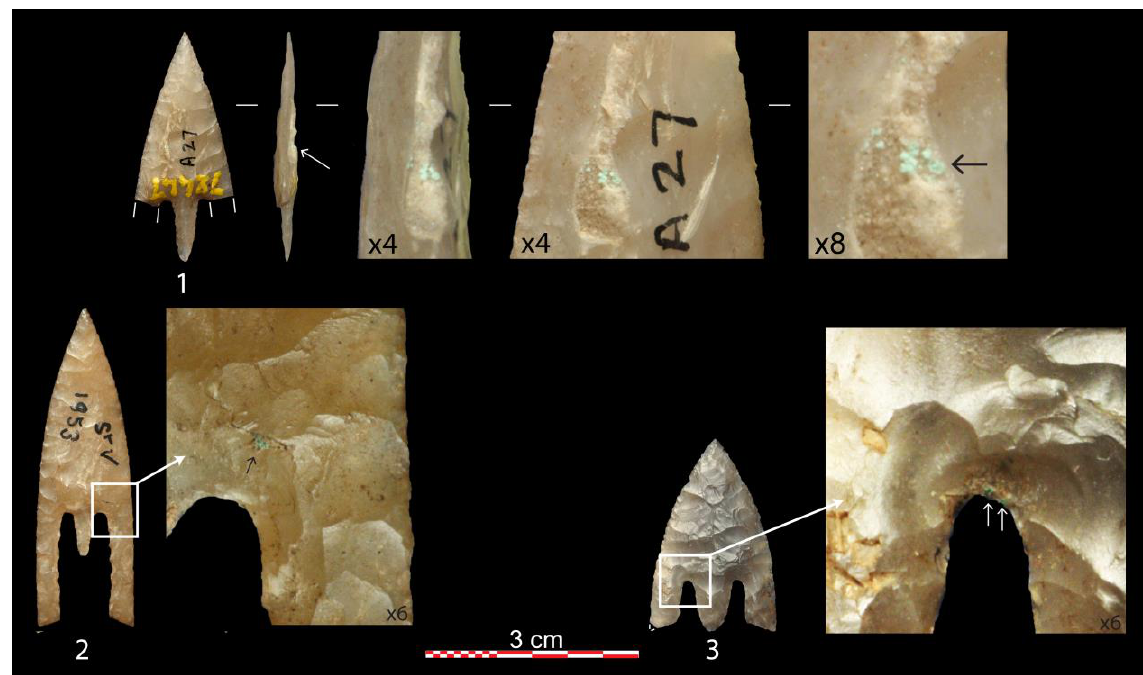
Figure 8. Greyish green traces on Armorican arrowheads indicating the use of copper (or copper alloy) awl for pressure-flaking (photo C. Nicolas). These greyish green traces are located in key spots of the chaîne-opératoire . The first one (1) is located on a crystalline inclusion of the flint, which has hampered the pressure flaking. The knapper succeeded in removing the left part of the inclusion but removals stopped against the left part, leaving a step 1,4 mm thick visible on the profile. The knapper tried to remove it by pressure. By this way, he managed to do three removals, clearly visible by two concave beginnings. Below the second concavity, we could see two greyish green traces, indicating a last attempt to do a fourth removal. In the two other cases, the knapper should have tried to eliminate a hinged removal (2) or to correct a slight asymmetry of the spaces between barbs and tang (3). 1. Tossen-Rugouec, Prat, Côtes-d’Armor; 2. Graeoc 2, Saint-Vougay, Finistère; 3. Rumédon, Ploumiliau,